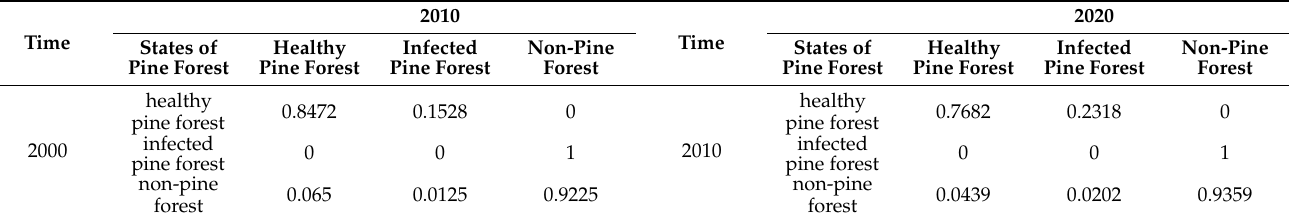
Table 1. Markov transition probability